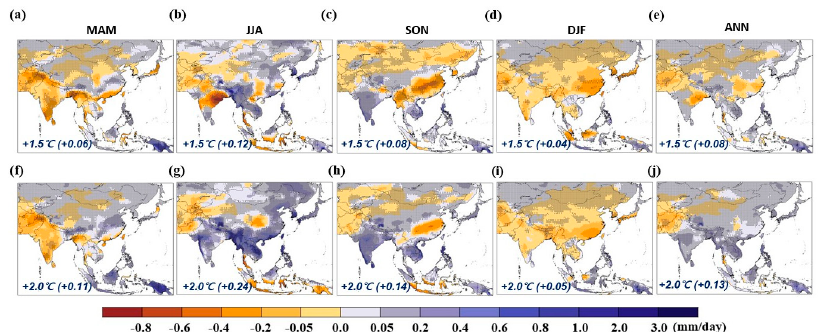
Figure 4. Spatial distribution of changes in ( a – d and f–i ) seasonal (March–April–May, MAM; June– July–August, JJA; September–October–November, SON; and December–January–February, DJF) and ( e and j ) annual mean precipitation (unit: mm/day) under 1.5 and 2.0 °C global warming compared to the reference period in the Asian monsoon region, respectively. The values in parentheses indicate the change in the area-averaged mean over the Asian monsoon region.